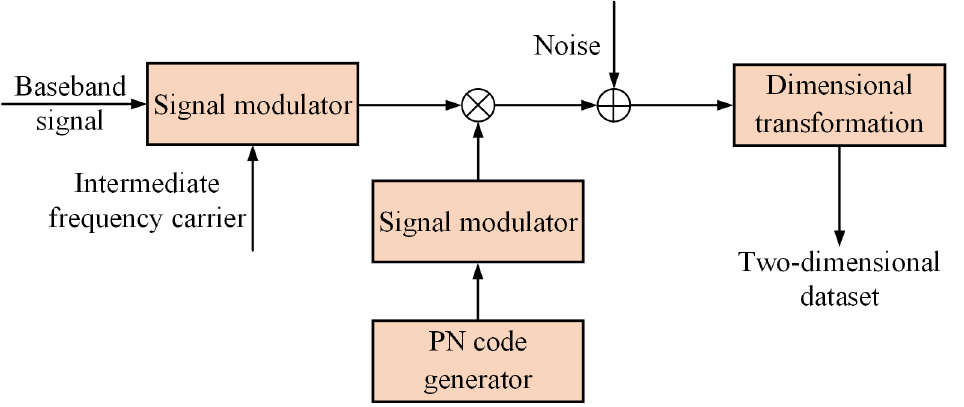
Figure 1. The generation of Unmanned Aerial Vehicles (UAV) remote signal